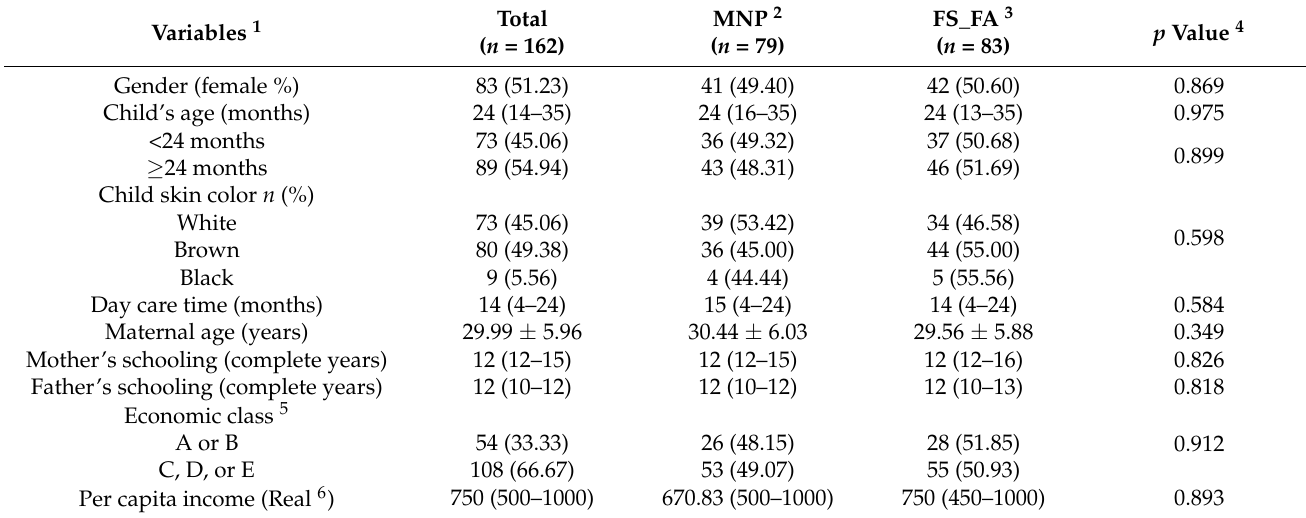
Table 1. Characterization of the sample at the baseline ( n = 162).